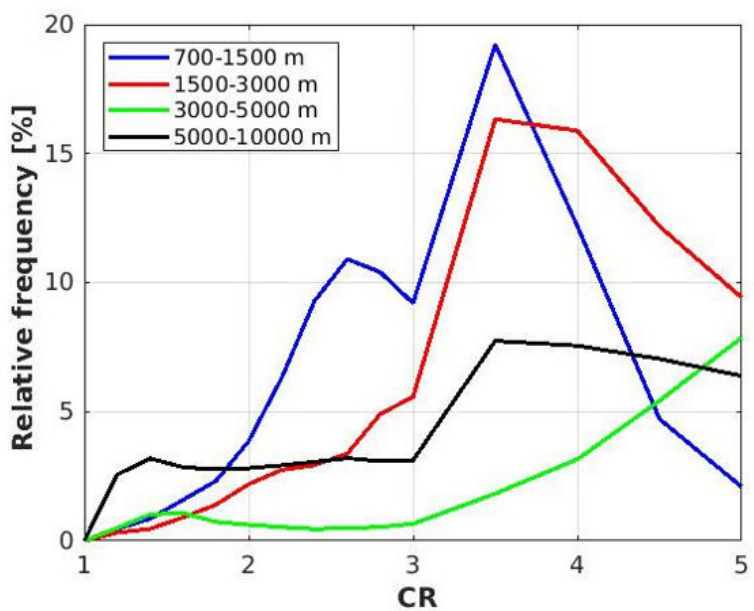
Figure 5. January–April: Frequency of the